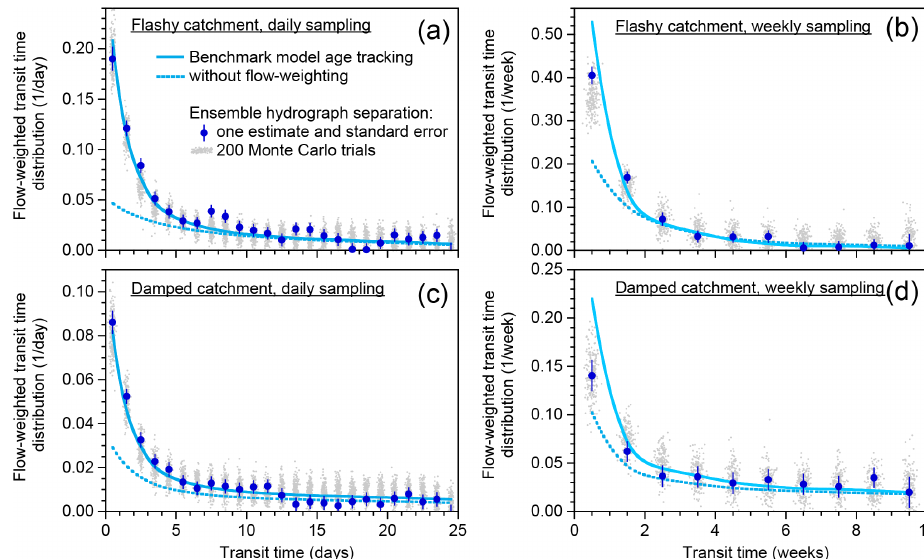
Figure 13. Volume-weighted transit time distributions (TTDs) of discharge estimated by ensemble hydrograph separation (Eq. 60) compared to benchmark model age tracking. Panels (a, b) and (c, d) show TTDs for rapid and damped response parameters, respectively; model is driven by Smith River precipitation in both cases. Ensemble hydrograph separation estimates from tracer fluctuations (dark blue symbols) are broadly consistent with true TTD from age tracking in the benchmark model (solid curve). Data clouds show ensemble hydrograph separation results (slightly jittered on the horizontal axis) from 200 different realizations of random precipitation tracer values, random missing data, and random measurement errors. Dashed curve is the unweighted benchmark model TTD from Fig. 11 for comparison.